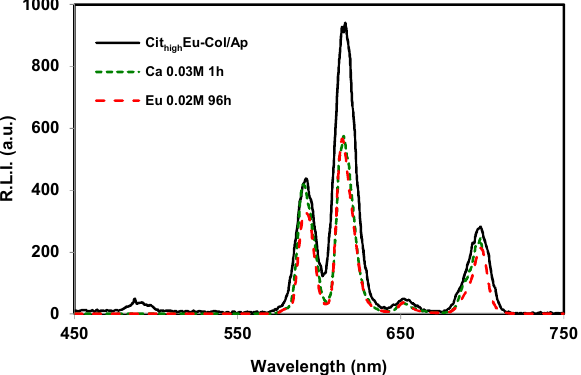
Figure 6. Uncorrected emission spectra of Cit high Eu – Col/Ap (solid black line), citrate – coated Eu 3+ – doped carbonated apatite nanoparticles (13.3 ± 2.6 wt % Eu) (dotted green line) and citrate – coated Ca 2+ – doped EuPO 4 .H 2 O (43.7 ± 0.3 wt % Eu, 4.9 ± 0.1 wt % Ca) nanoparticles (dashed red line).